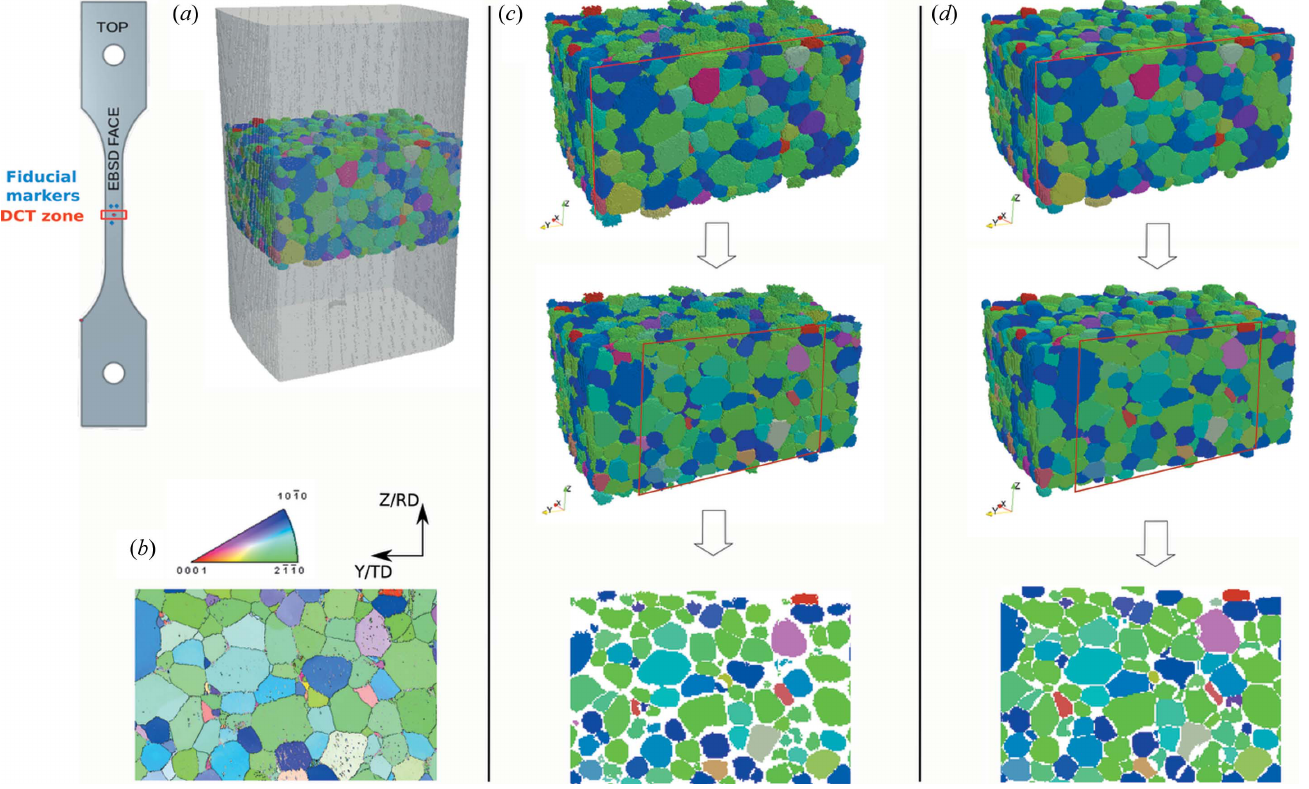
Figure 4 Visualization of DCTreconstructions in the undeformed configuration (IPF color coding along the z axis): ( a ) PCTreconstruction of the sample gauge length showing the DCT superimposed, ( b ) repolished EBSD map of the area corresponding to the DCT scan, ( c ) DCT SIRTreconstruction, ( d ) DCT 6DTV reconstruction; columns ( c ) and ( d ) show from top to bottom the full volume, the volume cropped as repolished and the slice corresponding to the EBSD